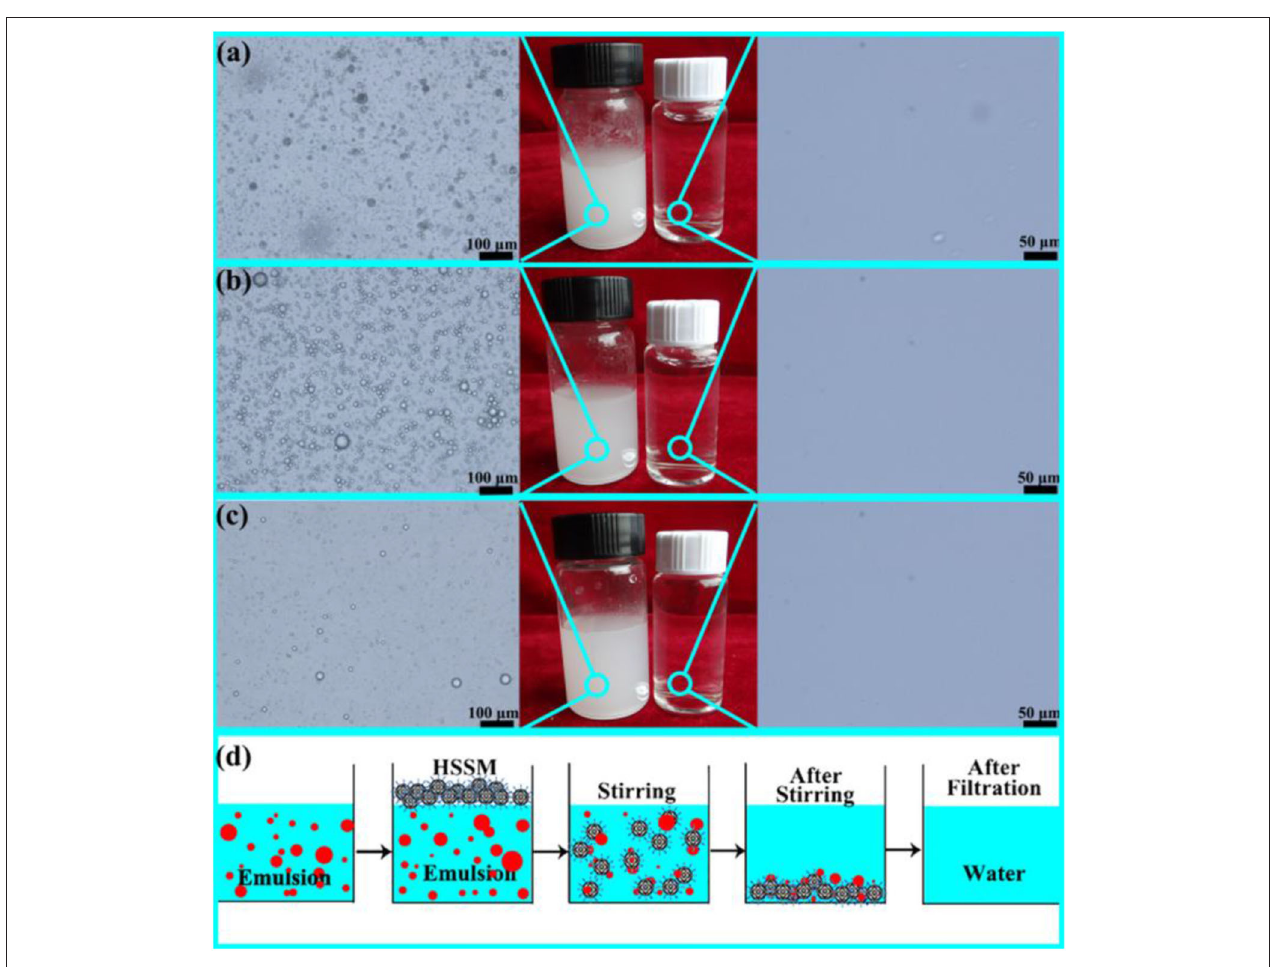
FIGURE 5 | (a) Optical microscopy of lubricating oil-in-water emulsions stabilized by sodium dodecylbenzene sulfonate (SDS) before (left) and after separation (right). Digital images of emulsion and separation product (middle) (b) . Optical microscopy of diesel oil-in-water emulsions stabilized by SDS before (left) and after separation (right). Digital images of emulsion and separation product (middle) (c) . Optical microscopy of n-hexadecane in water emulsions stabilized by SDS before (left) and after separation (right). Digital images of emulsion and separation product (middle) (d) . Schematic showing the separation process of oil/water emulsions (d) . Adapted from Guo et al. (2017b). With permission from Elsevier, copyright